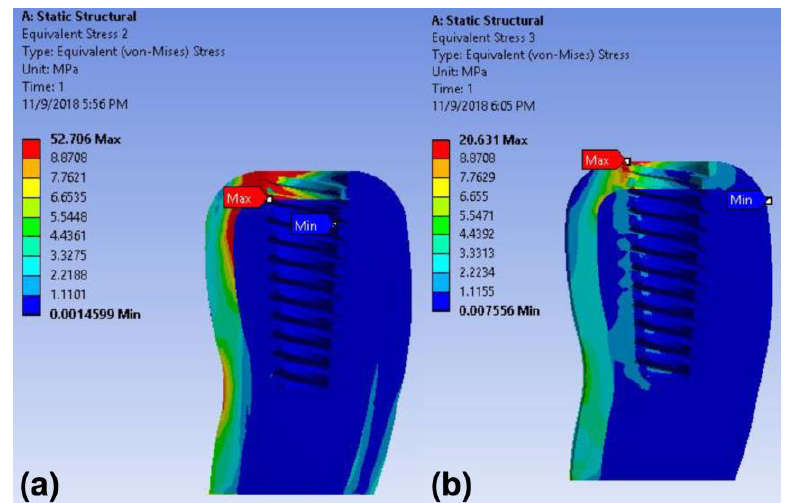
Figure 8. Color-coded von Mises stress distributions in the peri-implant bone under oblique load in the finite element model: ( a ) cement-retained zirconia crown model and ( b ) cementless screw-retained zirconia crown model.